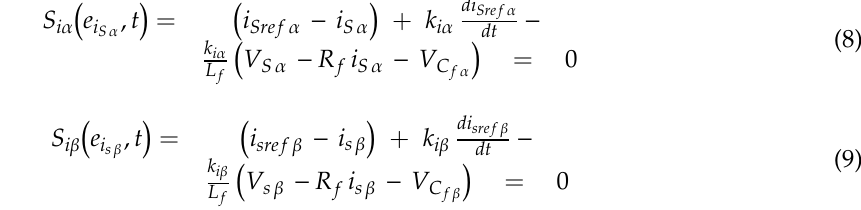
Figure 4. Vectors available in the αβ plane.